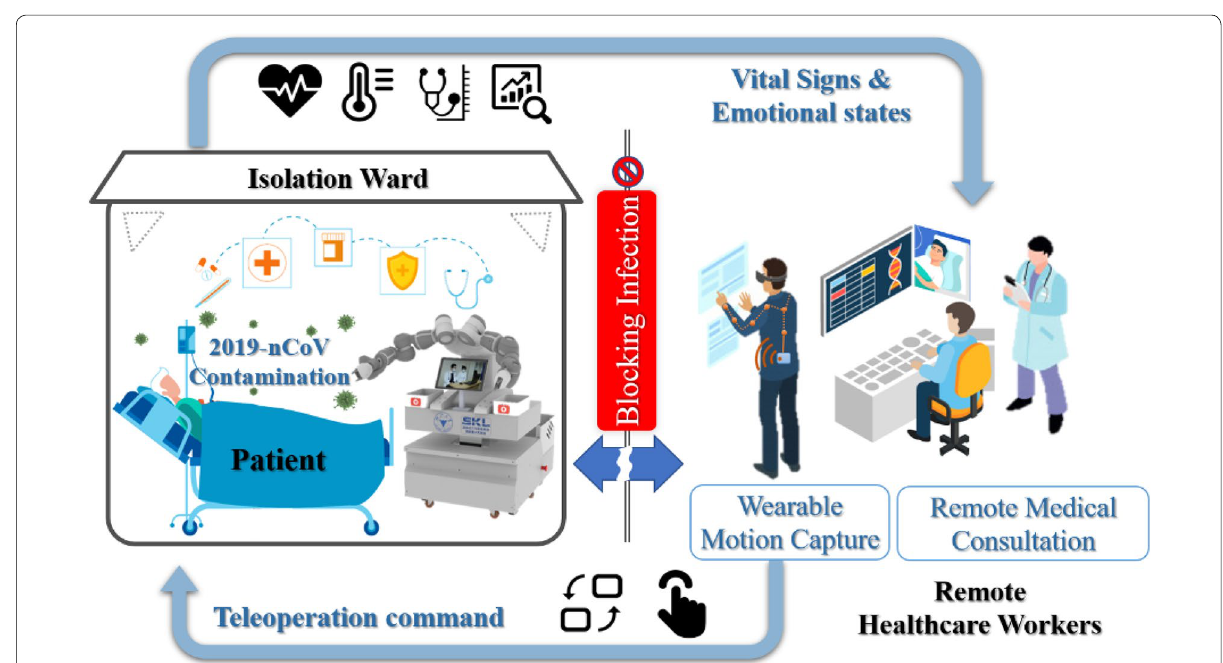
Figure 1 Schematic of the developed telerobotic system (Vectors of the patient and caregivers were designed by Freepik)